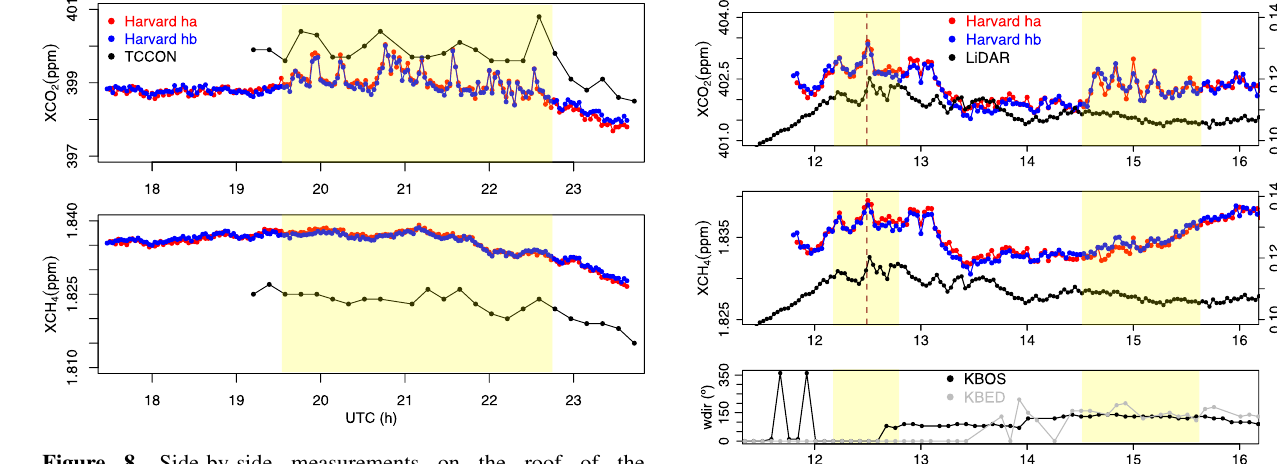
Figure 8. Side-by-side measurements on the roof of the Linde+Robinson Laboratory on Caltech campus (17 January 2015, 2min block average). Both EM27/SUN spectrometers captured short-term variations in the X CO signal ( ∼ 1ppm corresponds to 2 0.25% relative). The TCCON spectrometer does not resolve these short-term variations due to the low measurement rate. Figure 9. Short-term variations in X CO and X CH observed on 2 4 the roof of Harvard Science Center by ha and hb (16 April 2015, 2min block average). A lidar metric of the thickness of the PBL (mean NRB 0–1.5kma.g.l.) from a nearby site (Boston University, 3km to the south-southeast of our site) is overlaid on top. The NRB signal is positively correlated with the short-term variations of the FTS measurements at